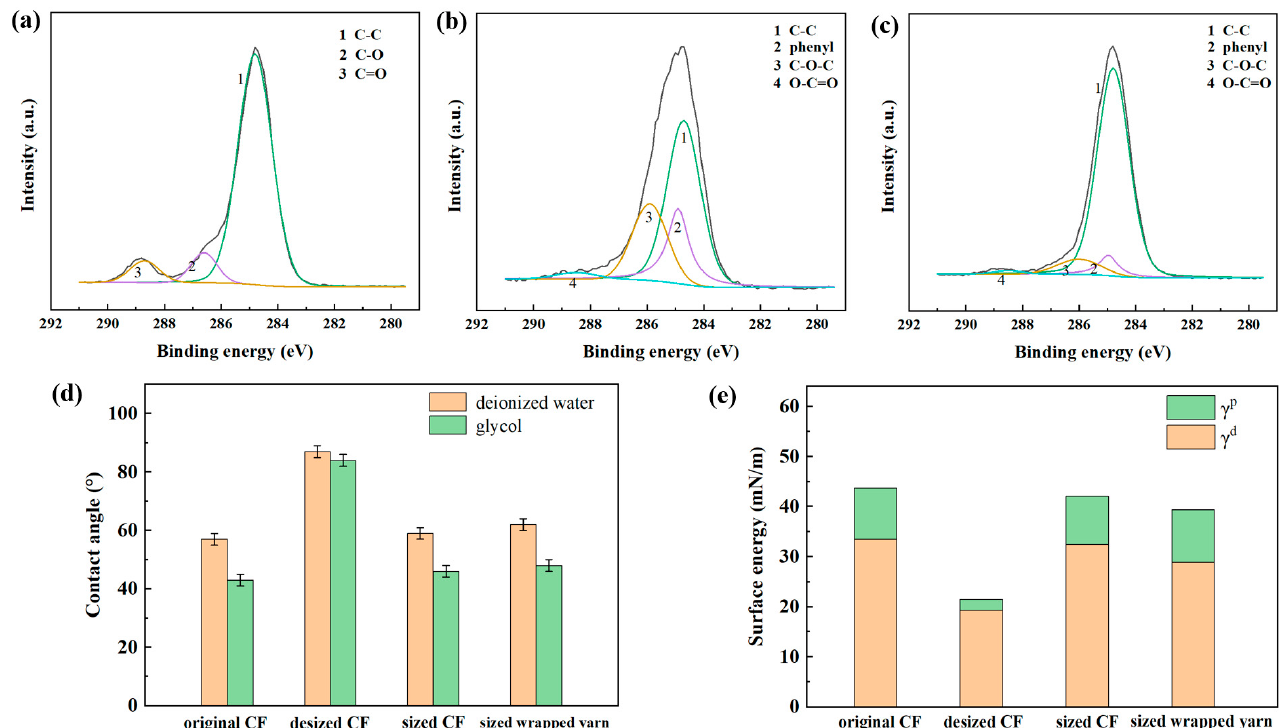
Figure 5. XPS spectra of ( a ) desized CF, ( b ) sized CF, and ( c ) sized CCF/PEEK wrapped yarn. ( d ) Contact angles and ( e ) surface energies of different fibers. ( d ) Contact angles and ( e ) surface energies of different